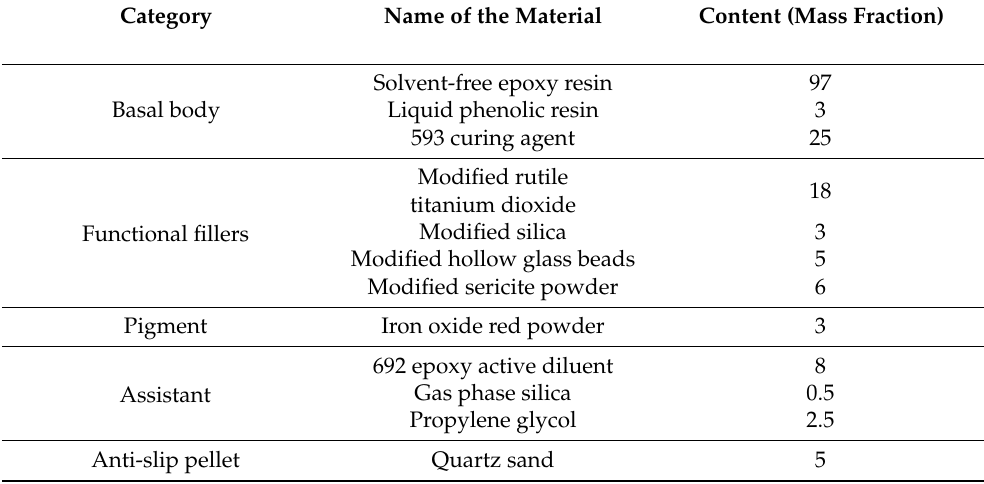
Table 7. Components of each material of heat-reflective asphalt pavement